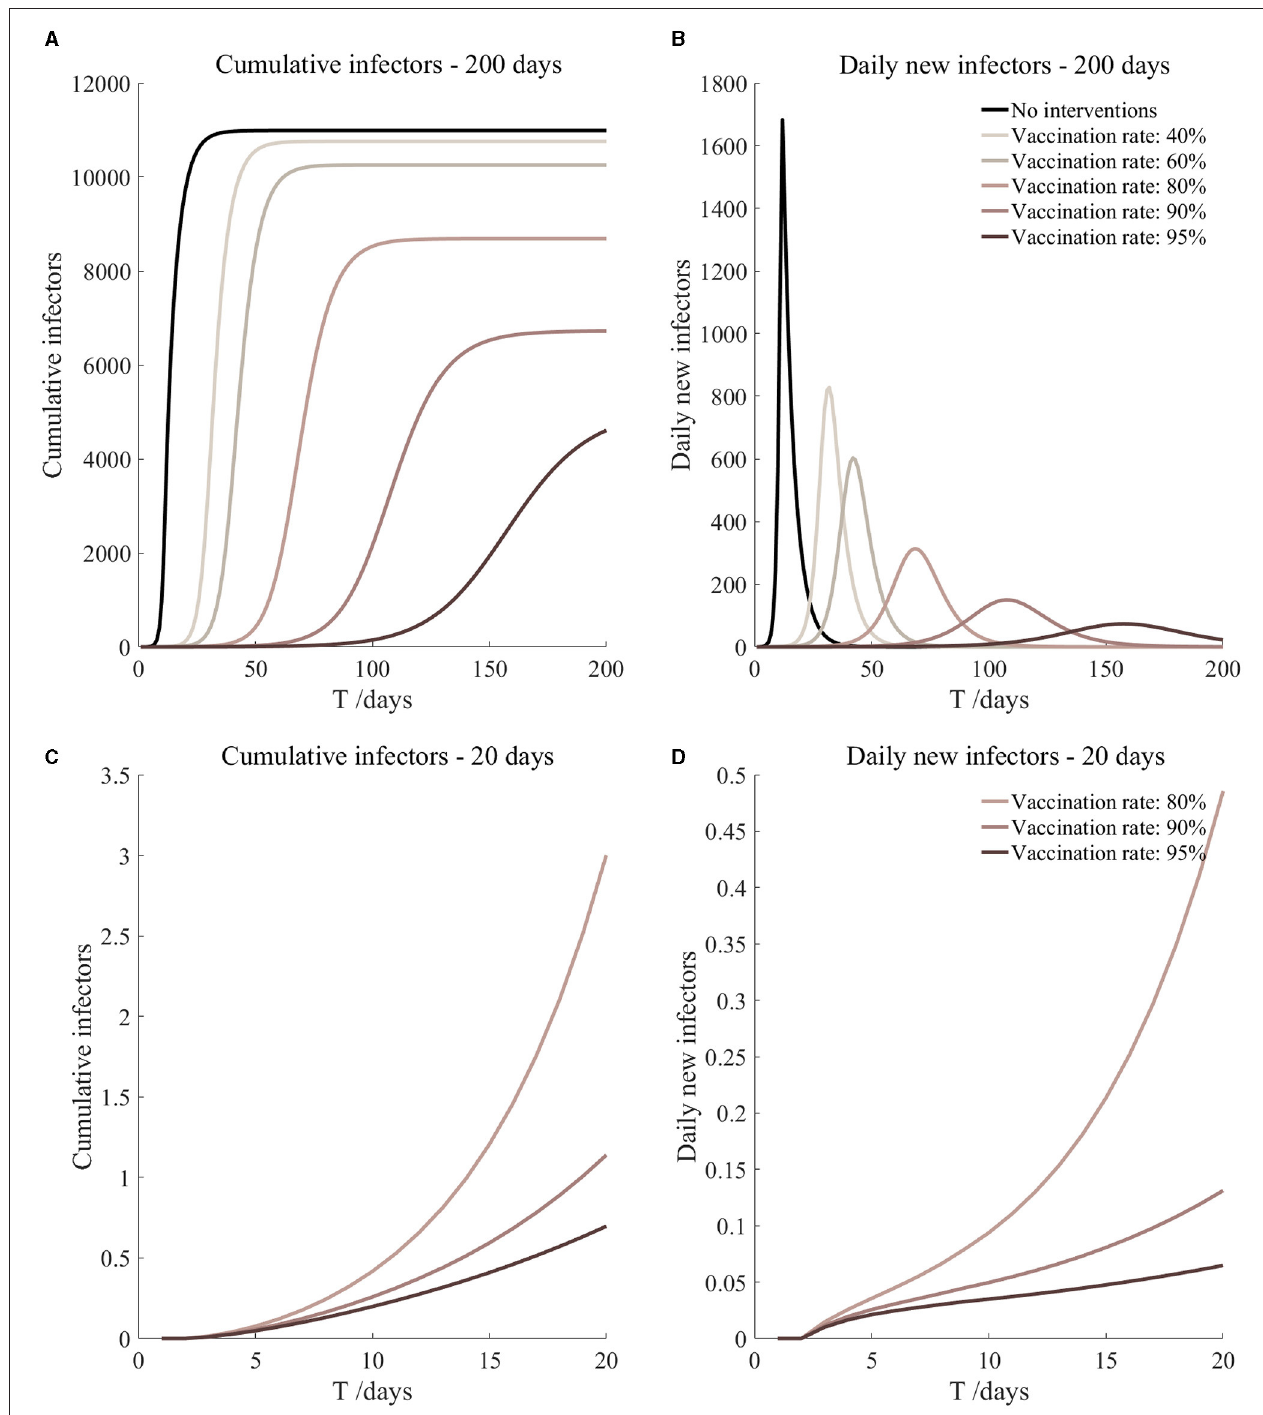
FIGURE 8 | Vaccination and 7-day compulsory quarantine. Assume pre-flight screening can identify 40% of asymptomatic infectors, 7-day compulsory quarantine has about an 18% risk of missed detection.